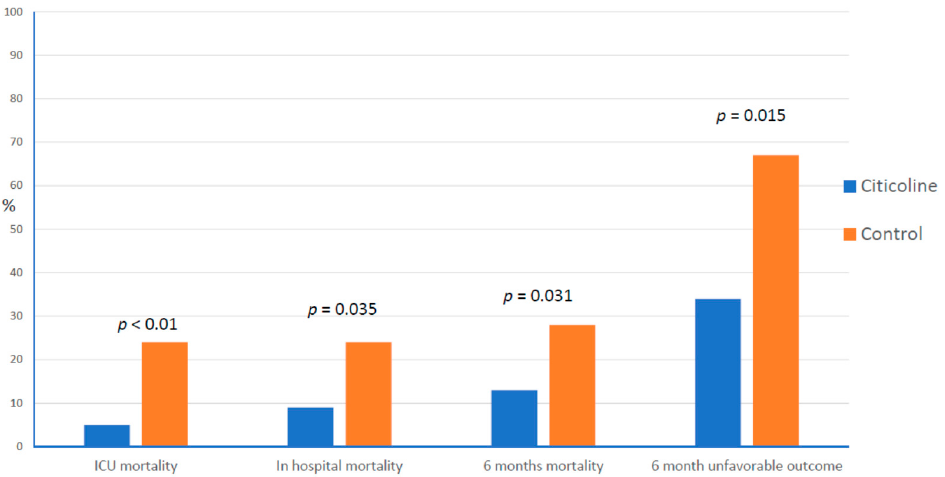
Figure 2. Effect of citicoline treatment on the rates of mortality and unfavorable outcome. ICU = Intensive Care Unit.